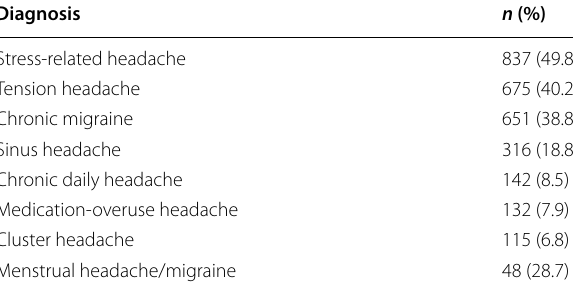
Table 3 Diagnoses received in the past by participants